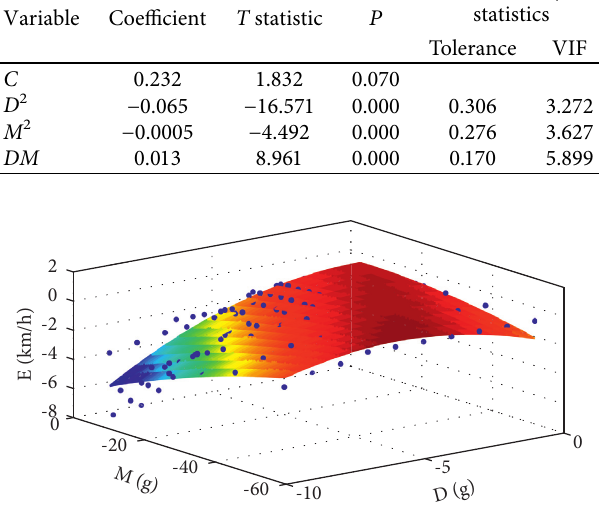
Figure 11: Three-dimensional graph of the velocity variation error- acceleration peak-discrimination threshold regression